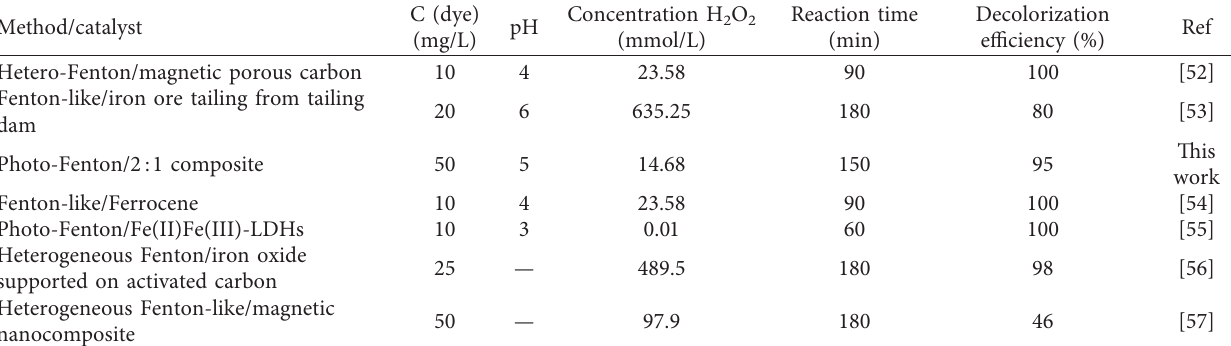
Table 2: Comparison of MB degradation for various methods and